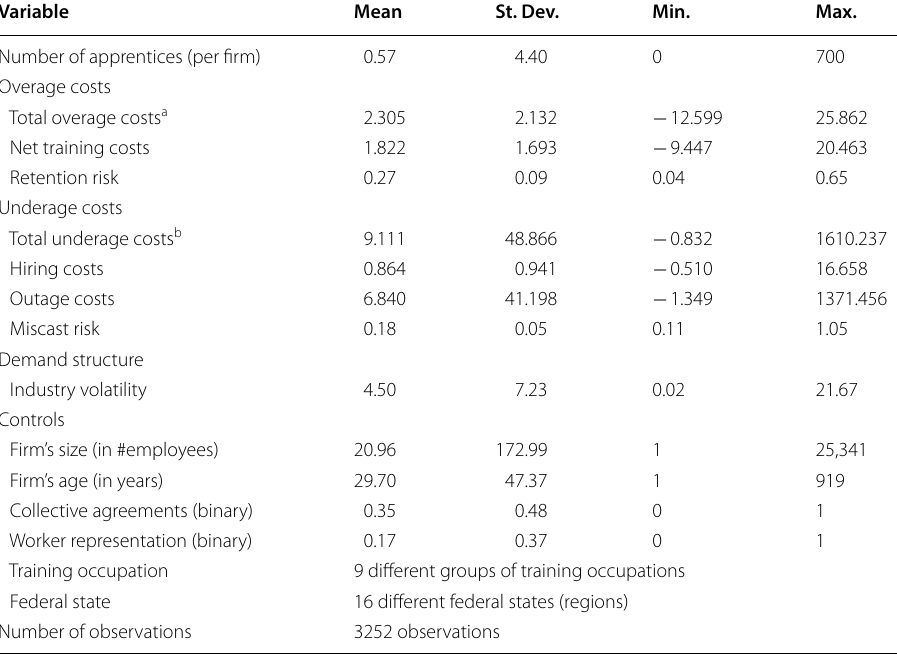
Table 1 Descriptive statistics—overview (full sample). Source BIBB CBS